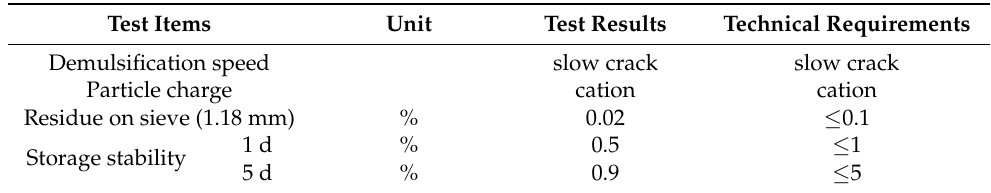
Table 2. Main technical indexes of emulsified asphalt.